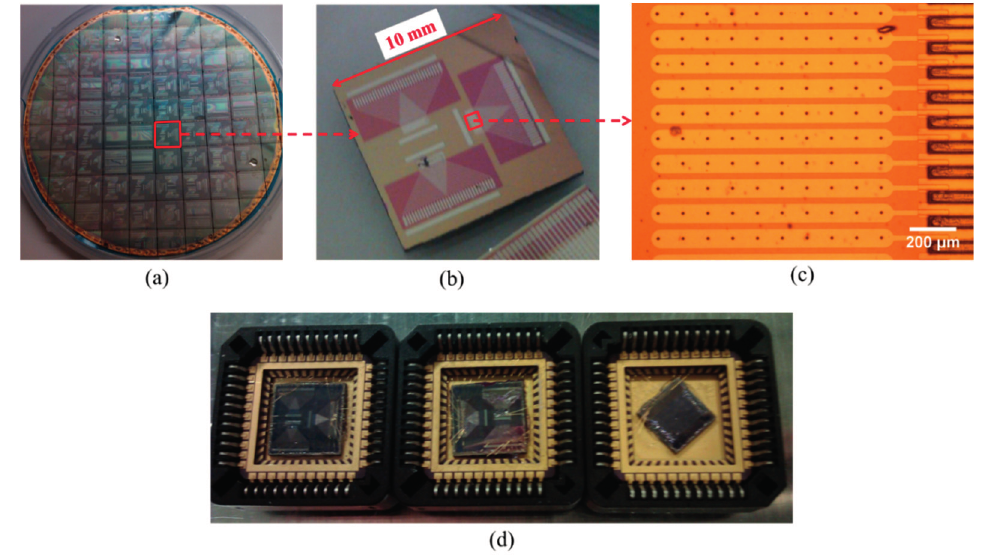
Figure 10. Images of ( a ) a 4-inch wafer with multiple PMUT dies with different diameter diaphragms; ( b ) three PMUT arrays on one die; ( c ) several elements of a PMUT array, each consisting of ten diaphragms; and ( d ) three fully packaged wire-bonded devices.